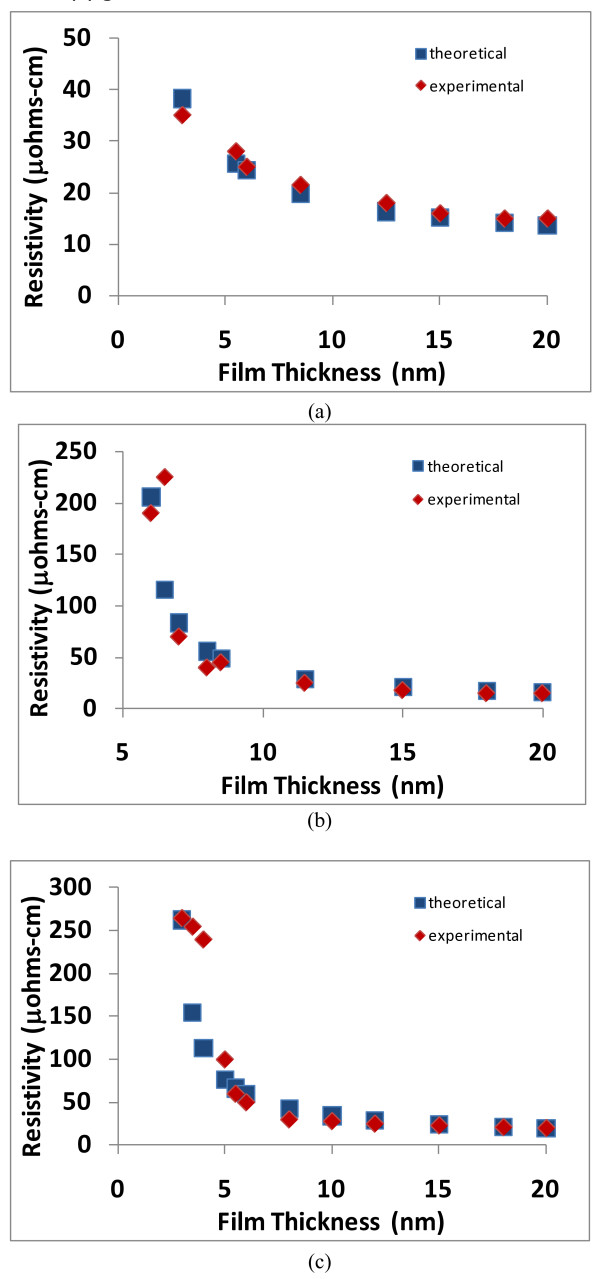
Comparison of theoretical and experimental resistivities for various metals as a function of film thickness. The materials in these graphs are (a) aluminum, (b) copper, and (c) gold (the experimental data is adapted from Camacho and Oliva [14]).